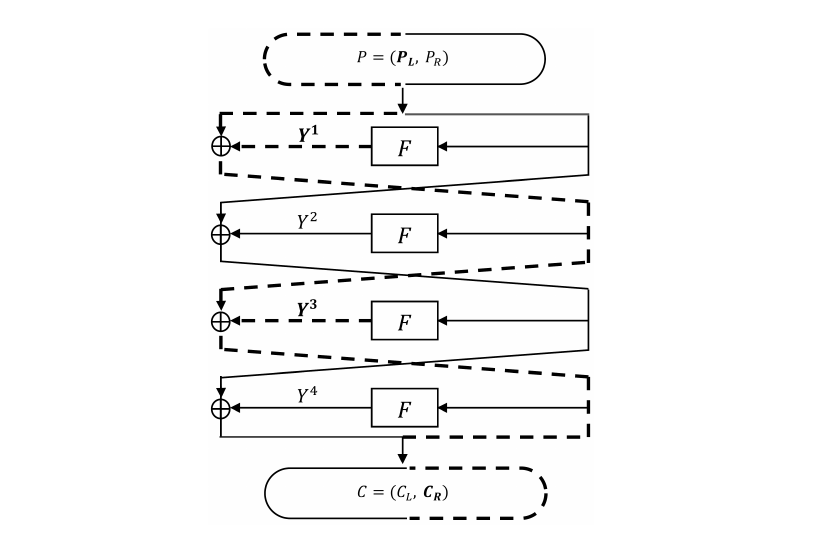
Figure 3: The XOR of the Odd Rounds in DES Reduced to Four Rounds, And its Equality to P L ⊕ C